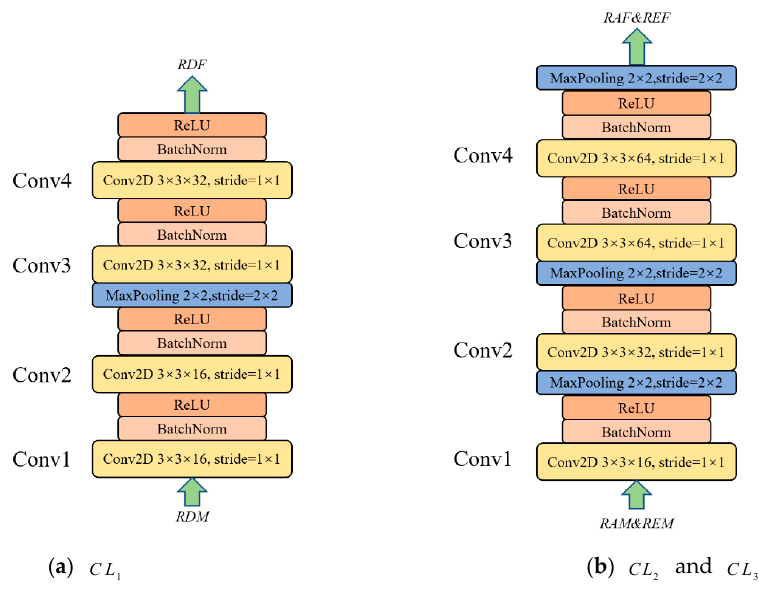
Figure 13. The structure of the spatial feature extraction module.